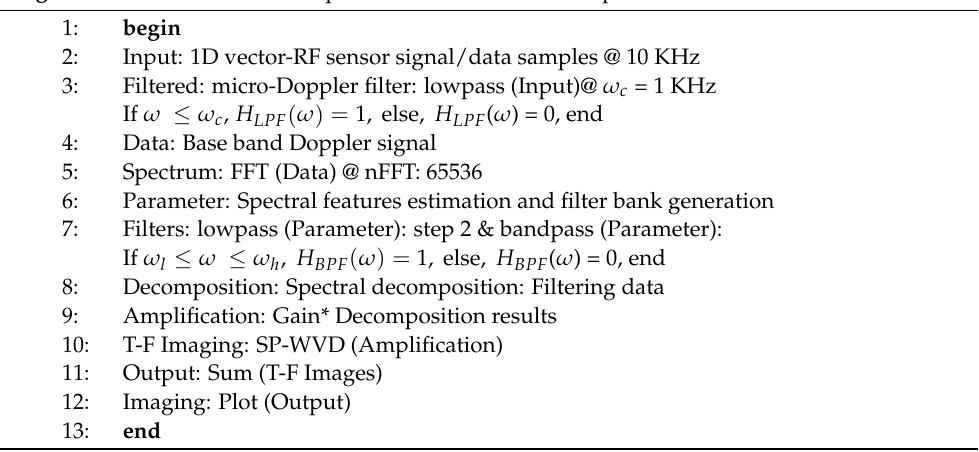
Algorithm 1. Pseudo Code: Proposed SP-WVD with an adaptive filter